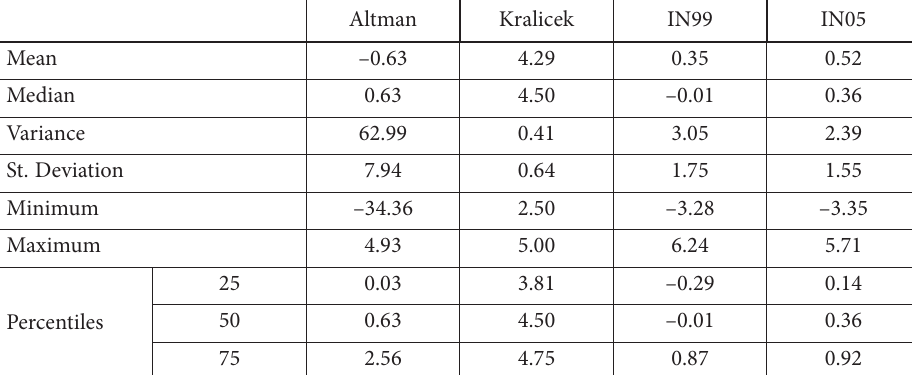
Table 11. Results for regularly publishing enterprises 3 years before (source: authors based on financial statements) Altman